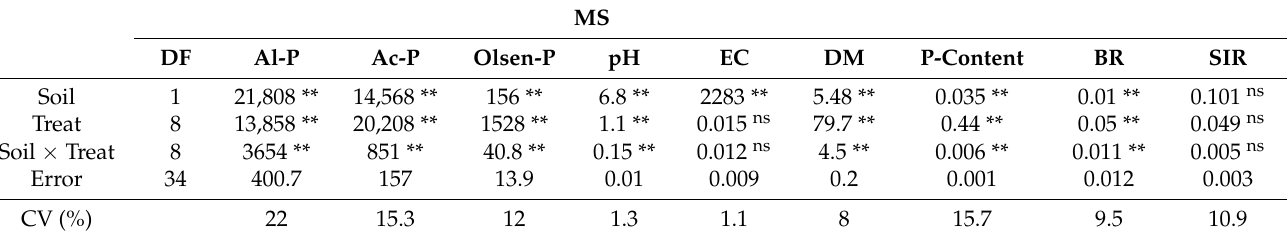
Table 6. Analysis of variance for Olsen-P and some soils biological indicator.